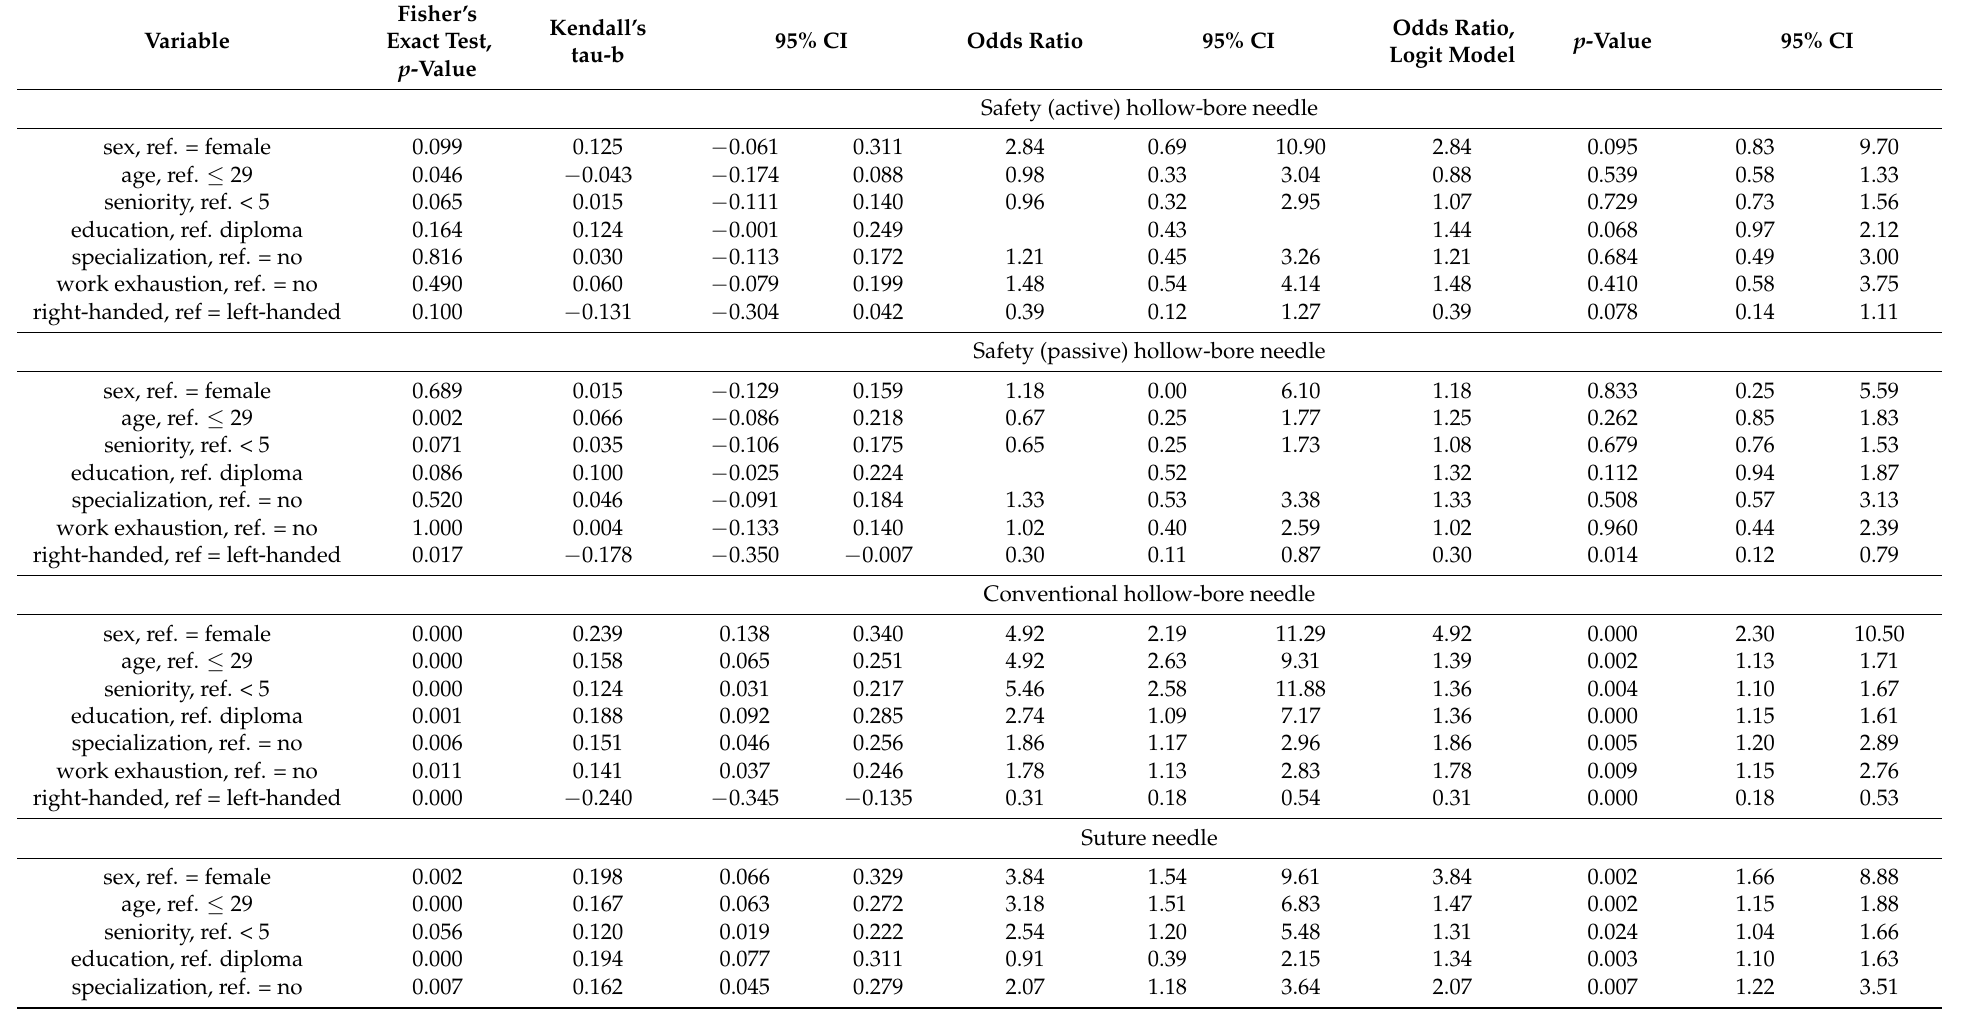
Table 4. Risk analysis of factors associated with the occurrence of sharp injuries with selected tools during the year preceding the